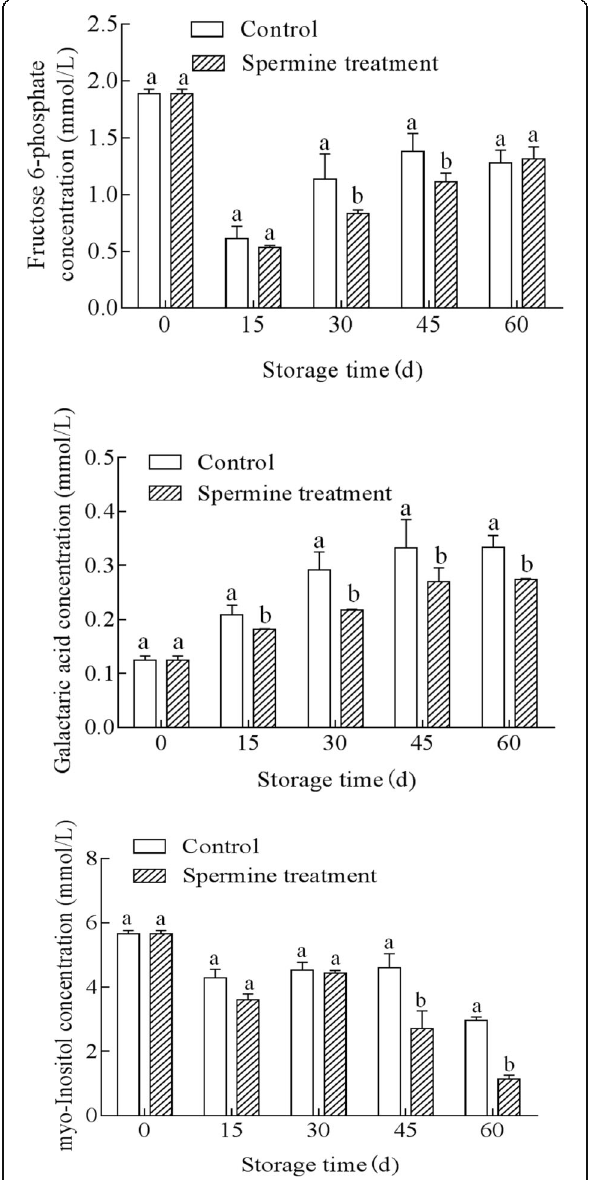
Fig. 3 Effect of exogenous spermine on the concentration of major sugars in cold-stored immature vegetable